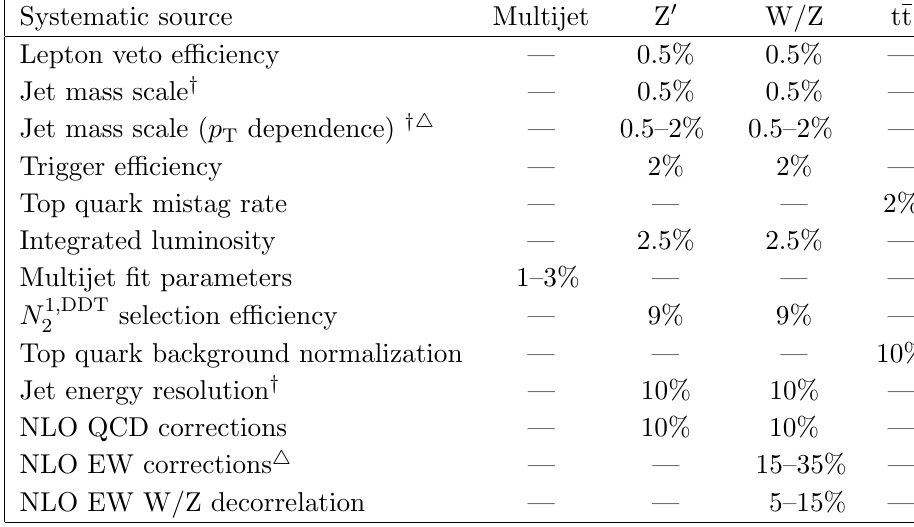
Figure 5 . Soft-drop jet mass distributions that pass (left) and fail (right) the N 1,DDT the semileptonic tt sample. Results of (cid:12)ts to data and simulation are shown.